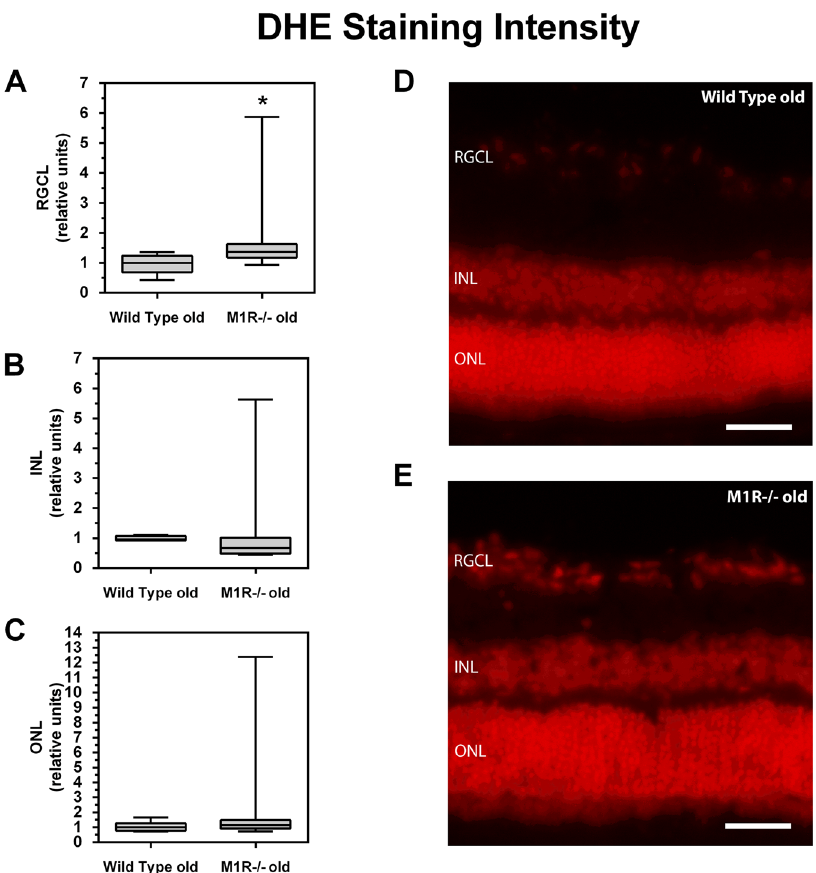
Figure 6. DHE staining intensity in the retinal ganglion cell layer (RGCL, A ), the inner nuclear layer (INL, B ) and the outer nuclear layer (ONL, C ) in aged wild-type and M1R − / − mice. DHE staining intensity was markedly elevated in the RGCL of aged M1R − / − mice ( * P < 0.05) suggesting higher ROS levels. Pictures of DHE-stained retinal cryosections for aged wild-type ( D ; scale bar 50 μ m) and M1R − / − mice ( E ; scale bar 50 μ